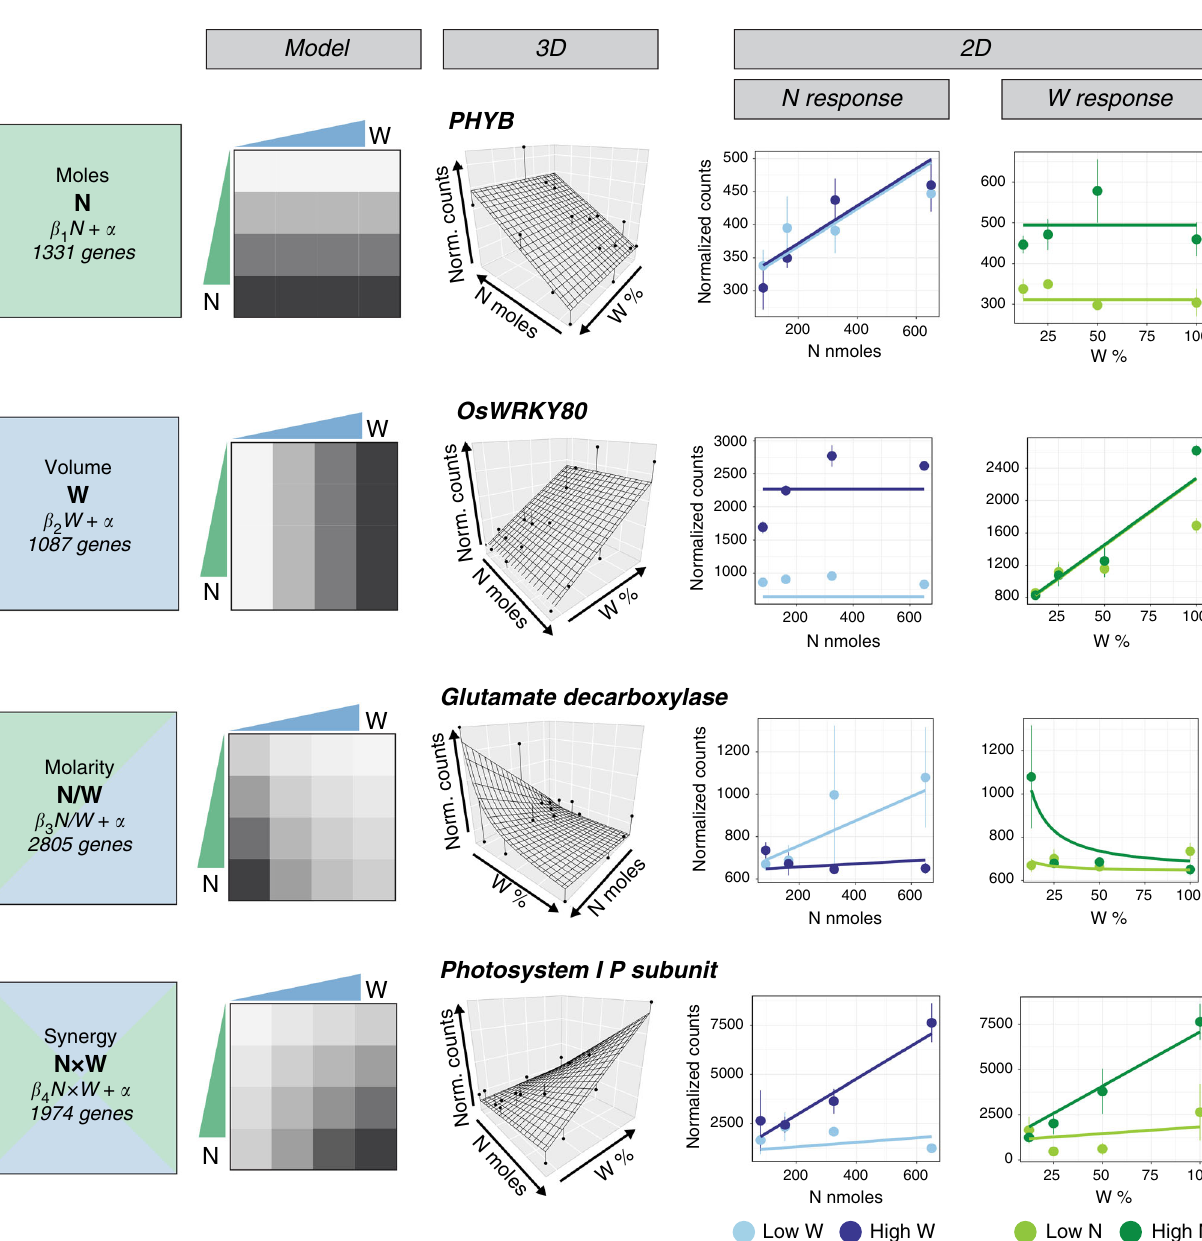
Fig. 2 Linear modeling of genome-wide expression data uncovers four main responses to changes in N -moles and/or W -volume. a Expression of 1331 genes are dose-dependent on N -moles. PHYB expression, an example fi tted by the N -moles model, is shown in three dimensions. PHYB is also plotted in two dimensions, showing its response to changes in N -moles under the lowest and highest W -volume provided (light blue: low W, dark blue: high W, error bars indicate SEM), and showing its response to changes in W -volume under the lowest and highest N -mole amounts provided (light green: low N, dark green: high N). b Expression of 1087 genes exhibit dose-dependent responses to changes in W -volume; OsWRKY80 is an example. c Expression of 2805 genes exhibit dose-dependent responses to changes in N -molarity ( N / W ); glutamate decarboxylase is an example. d Expression of 1974 genes respond synergistically ( N × W ) to changes in N- and W-dose; photosystem 1 P-subunit is an example. Figure 2 source data are provided in Source Data fi